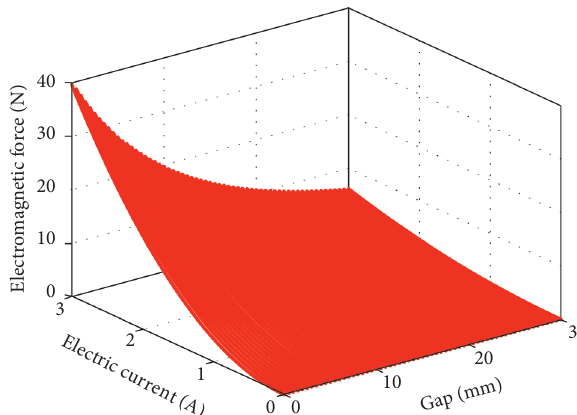
Figure 2: Simulation results in COMSOL multiphysics.